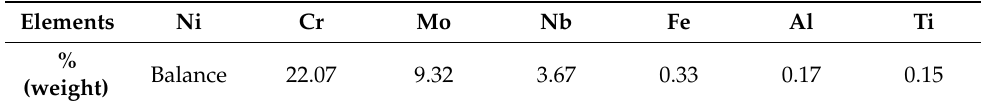
Table 2. Chemical composition of the Inconel 625 powder